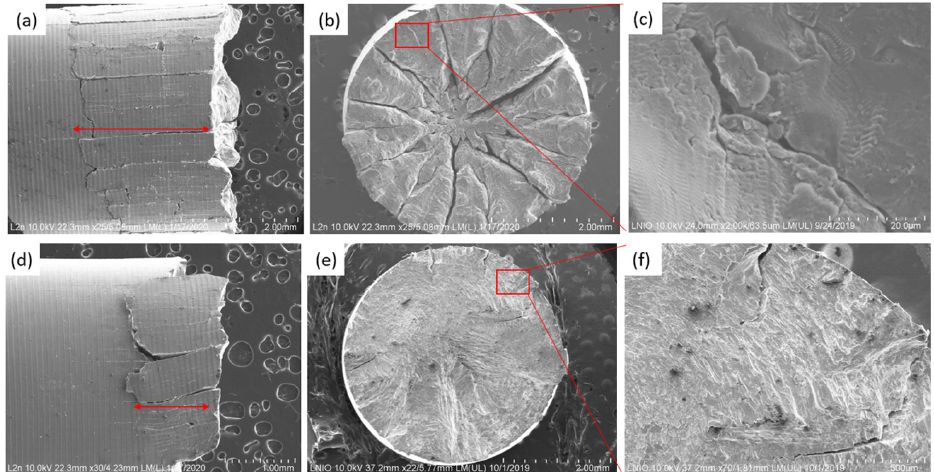
Figure 6. Fracture morphologies of HT samples: ( a – c ) correspond to 210 MPa, and ( d – f ) correspond to 170 MPa. Among these figures, circumferential surfaces ( a , d ), fracture surfaces ( b , e ), and magnified views ( c , f ) of red rectangles shown in ( b , e ) are shown, respectively.